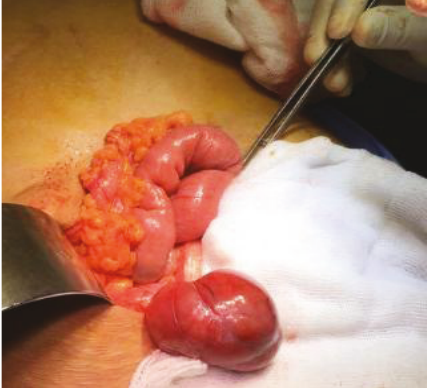
Figure 3: Intraoperative picture showing pedunculated mass arising from the caecum.